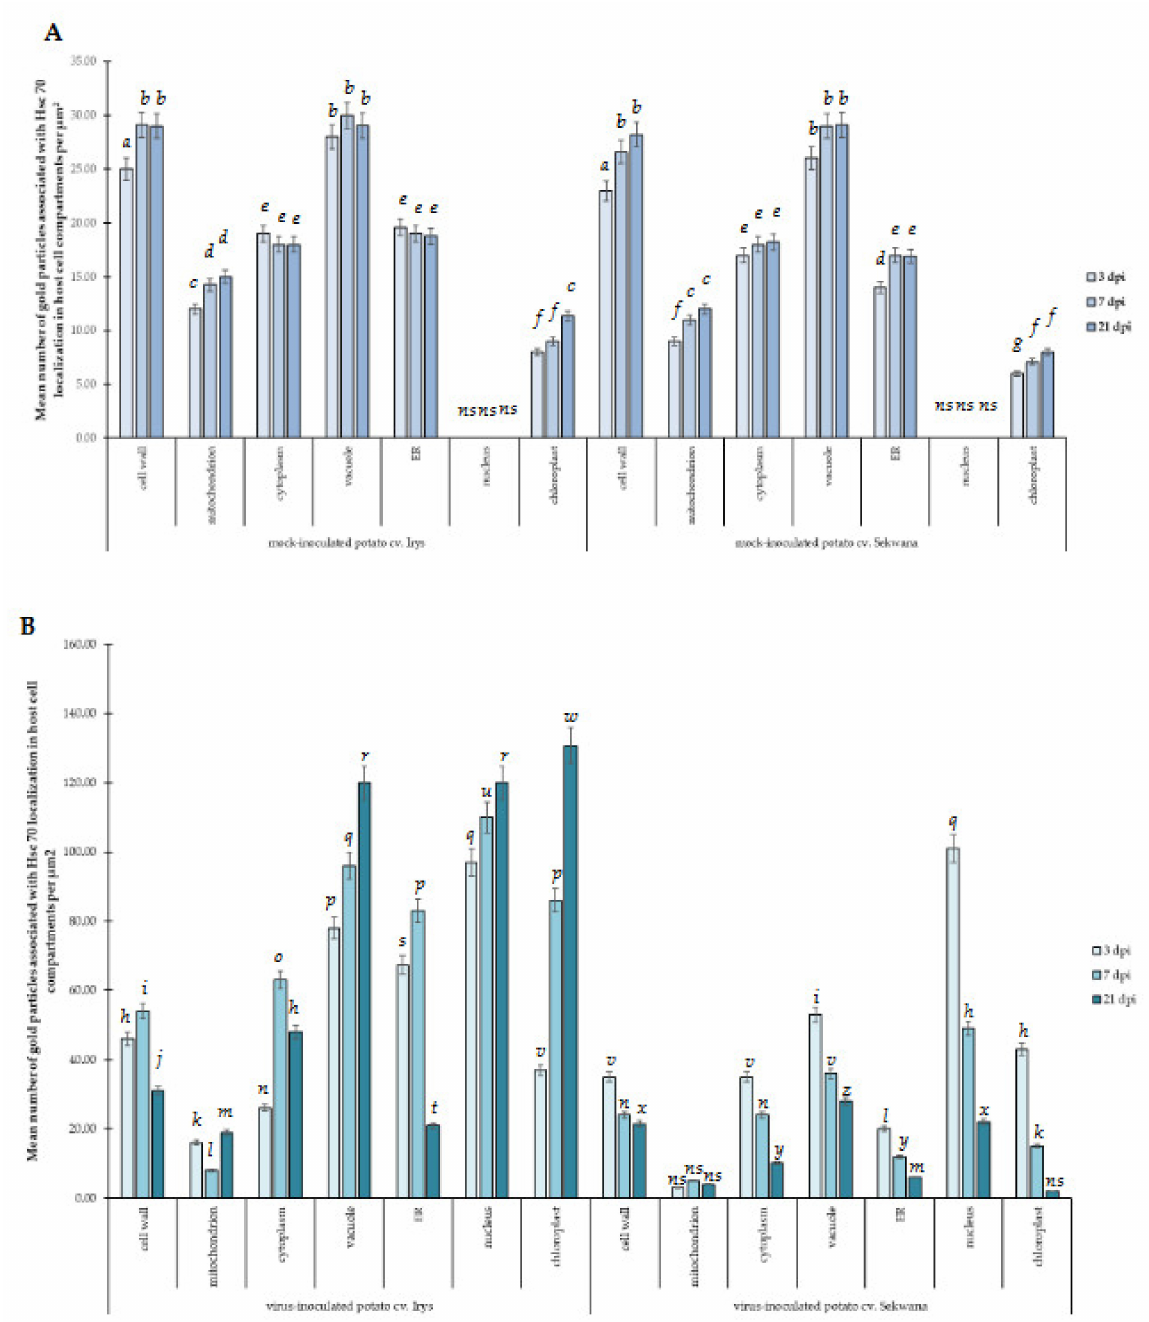
Figure 11. Statistical significance of HSC70 immunogold localization in host cell compartments of mock- ( A ) and PVY- inoculated ( B ) potato plants (susceptible Irys and resistant Sekwana). The figure presents the mean numbers of gold particles located in specific compartments per µ m 2 at 3, 7, and 21 dpi in mock- and virus-inoculated plants of both cultivars. Quantification of immunogold localization was performed using ANOVA. The mean values were calculated at p < 0.05 using the post hoc Tukey’s HSD test. Statistically significant values at 3, 7, and 21 dpi in mock- or virus-inoculated plants are marked with different letters above the bars. Nonsignificant values are marked as ns